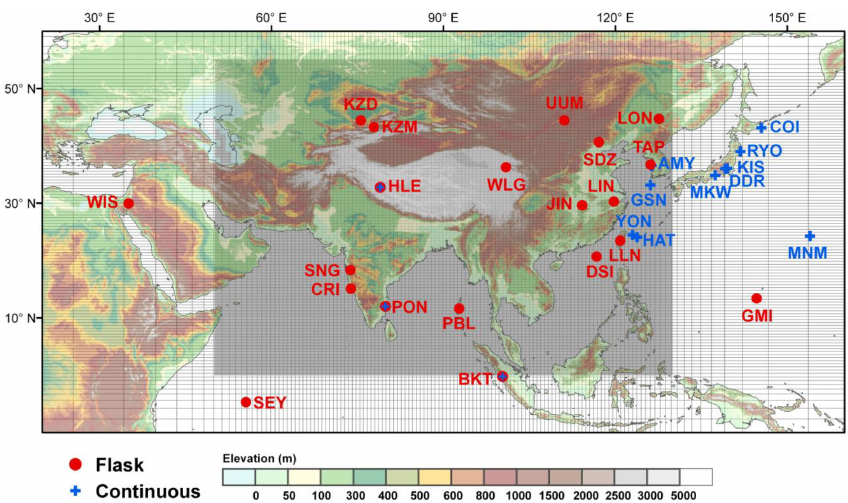
Figure 1. Map of locations of stations within and around the zoomed region. The zoomed grid of the LMDz-INCA model is plotted with the NASA Shuttle Radar Topographic Mission (SRTM) 1km digital elevation data (DEM) as background (http://srtm.csi.cgiar.org, last access: 6 March 2015). The grey shaded area indicates the region with a horizontal resolution of ∼ 0 . 66 ◦ × ∼ 0 . 51 ◦ . The red close circle (blue cross) represents the atmospheric station where flask (continuous) measurements are available and used in this